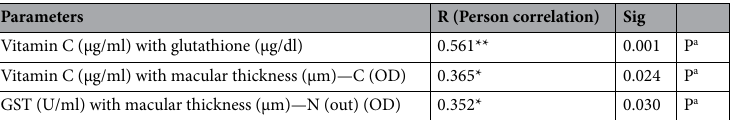
Table 6. Pearson’s correlations between the measured parameters. * Correlation is significant at the 0.05 level. ** Correlation is significant at the 0.01 level. a Positive correlation.